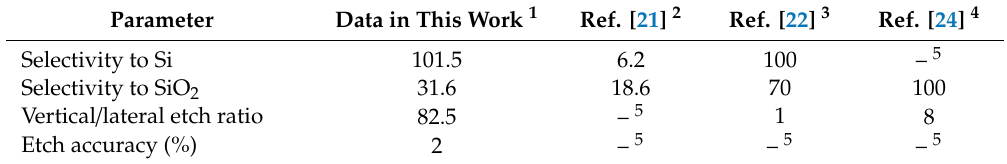
Table 1. Selectivity of SiN etch to Si and SiO 2 , vertical/lateral etch ratio and etch accuracy for SiGe/Si inner spacer structure.